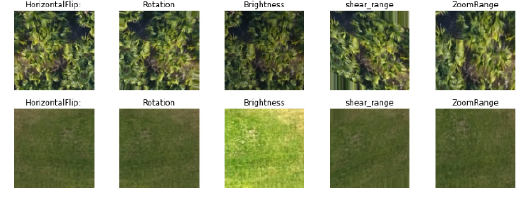
Figure 3: Augmented scenes